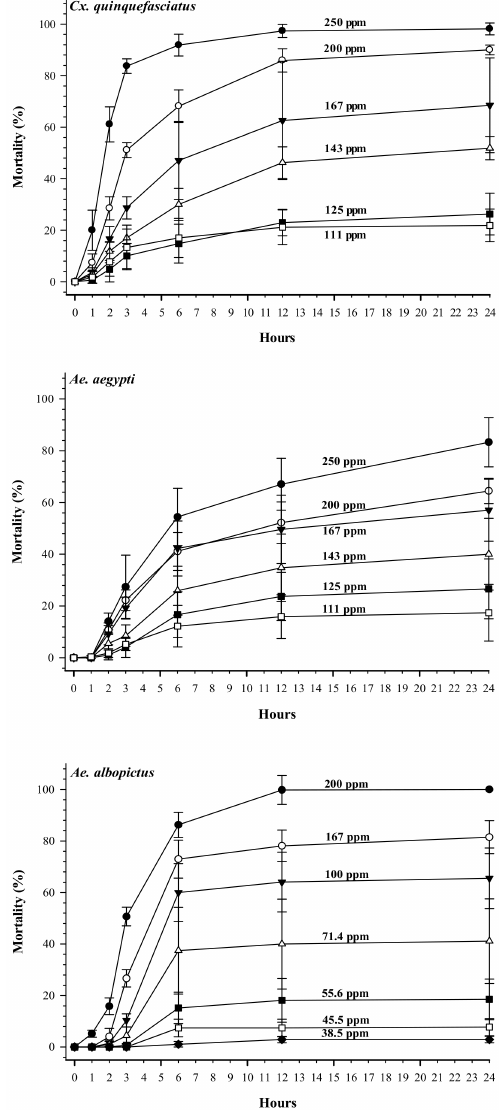
Figure 5. Time effects of terahertz-based functional mineral water on mosquito pupal mortality (%). On the second day of pupation, the mosquito pupae were transferred to a solution containing various concentrations of terahertz-based functional mineral water. The pupal mortality rate was recorded at various time points as indicated on the x-axis. Data are presented as mean ± SE values from at least three independent experiments, and different letters indicate significant differences ( p <